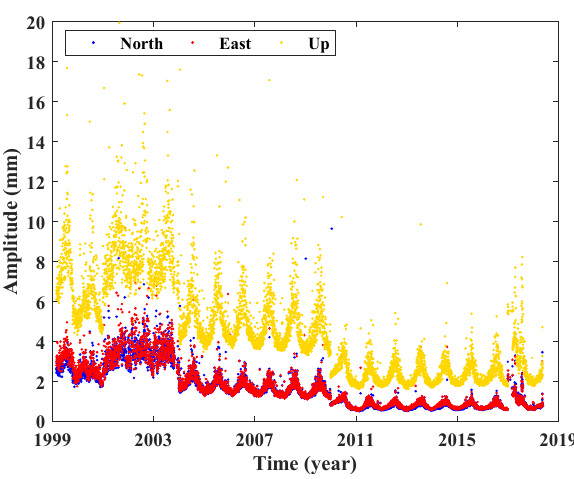
Figure 6. Reconstructed components of BJFS station using wavelet analysis.